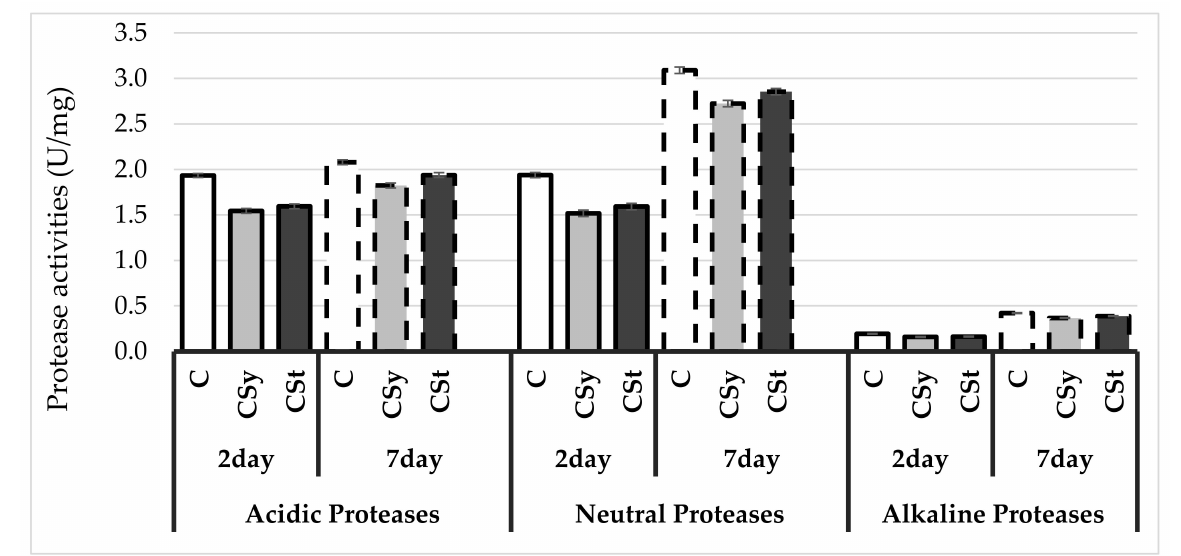
Figure 2. Protease activities in the 2- and 7-day-old honey bees’ hemolymph after two methods of supplementation with hemp extract: C–control (pure sugar syrup), Csy–hemp extract in syrup, Cst–hemp extract on strips (Two-Way ANOVA: Acidic Proteases: supplementation method: F (2,59) = 87.226, p = 0.000; days of supplementation: F (1,59) = 145.78, p = 0.000; supplementation method*days of supplementation F (2,59) = 7.8591, p = 0.00094, Neutral Proteases: supplementation method: F (2,59) = 74.315, p = 0.000; days of supplementation: F (1,59) = 1853.4, p = 0.000; supplementation method*days of supplementation F (2,59) = 1.3401, p = 0.26966, Alkaline Proteases: supplementation method: F (2,59) = 59,780, p = 0.000; days of supplementation: F (1,59) = 4008.1, p = 0.000; supplementation method*days of supplementation F (2,59) = 3.3549, p = 0.04169).